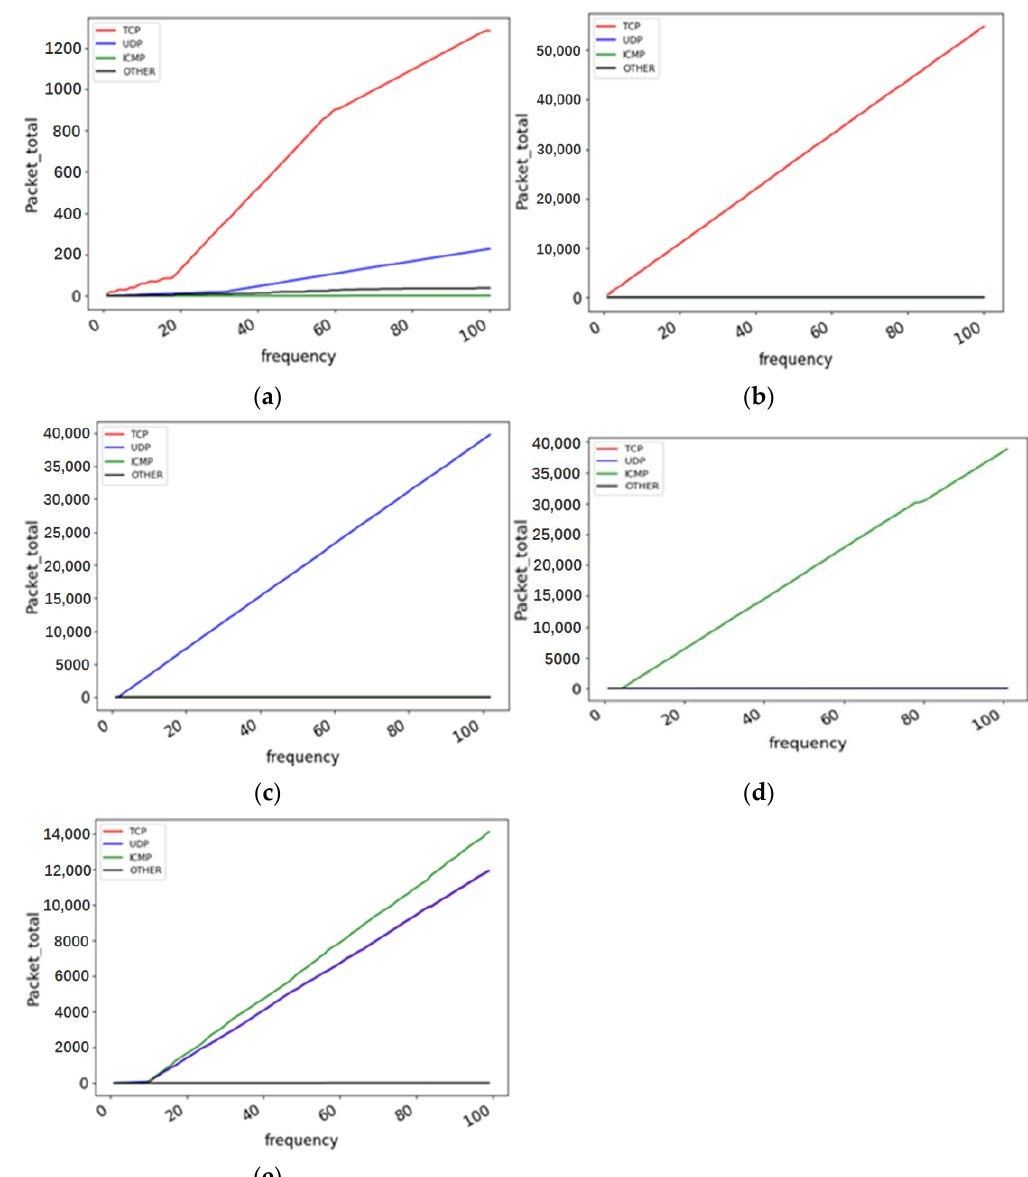
Figure 16. Packet flow cumulative diagram. ( a ) Normal transmission; ( b ) SYN flood attack; ( c ) UDP flood attack; ( d ) ICMP flood attack; ( e ) MIX flood attack.